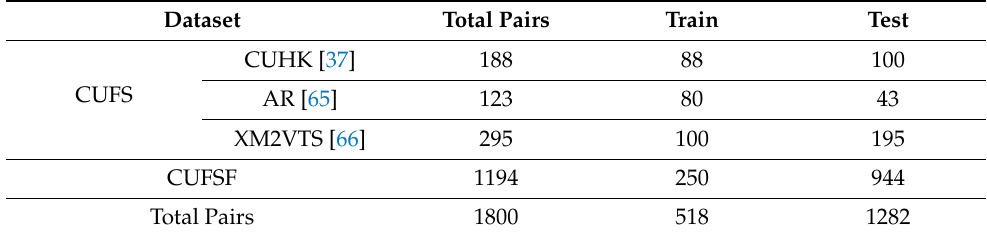
Table 1. Details of initial